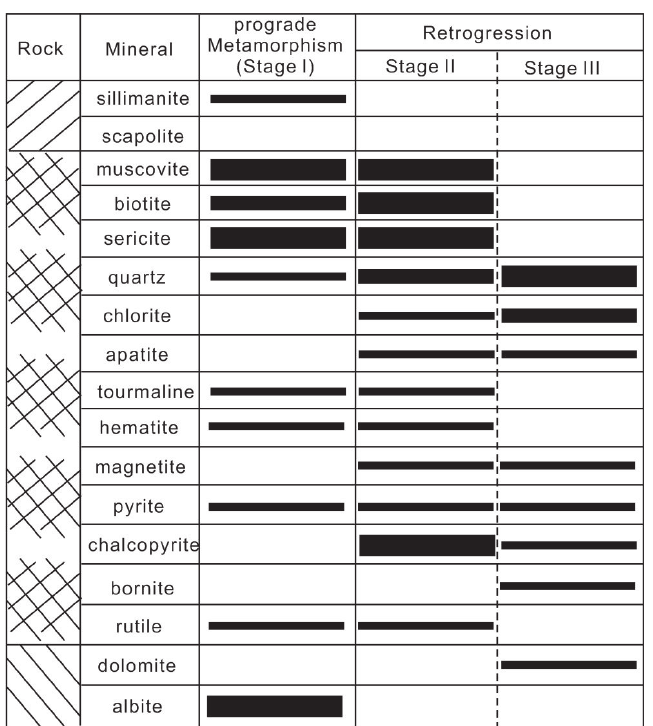
Figure 4. Mineral sequences occurred during peak and retrograde metamorphism at the Tongkuangyu copper deposit, North China Craton. Note that sillimanite and scapolite are only present in the mafic rocks (denoted by slash lines in the first column), albite and dolomite are only present in felsic rocks (denoted by reverse slash lines in the first column), and all other minerals are present in both lithologies. The thickness of the bars represents the relative amount of mineral in each